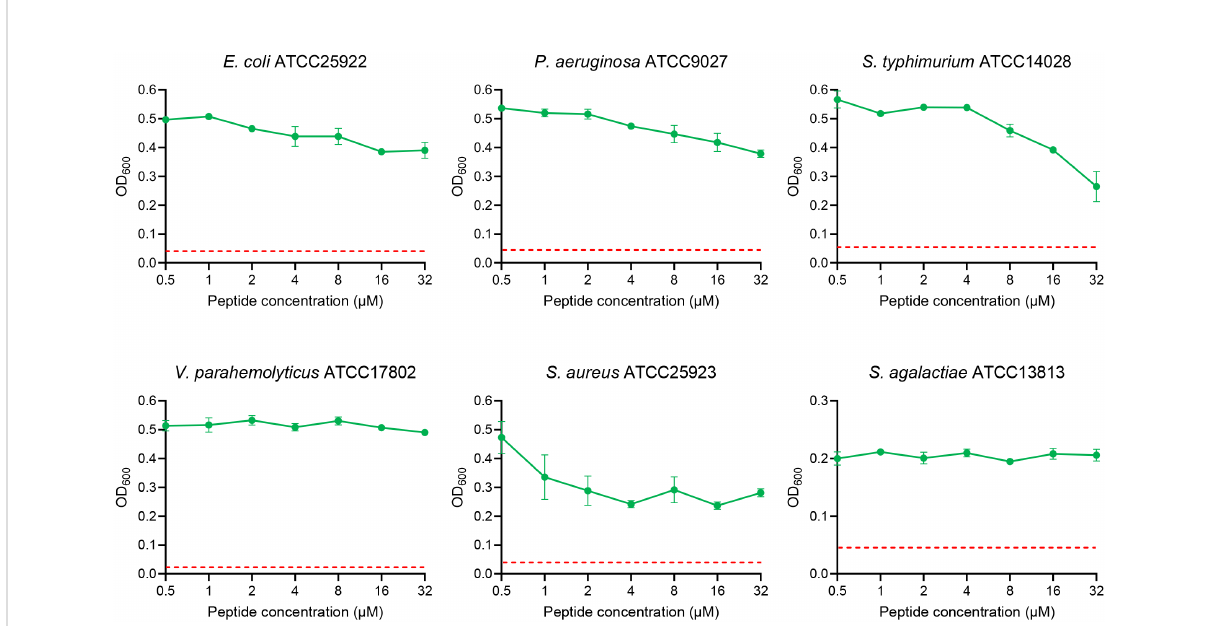
FIGURE 3 Antimicrobial activity of SKL17-2 against E. coli , P. aeruginosa , S. typhimurium , V. parahemolyticus , S. aureus , and S. agalactiae . The red dotted line represents the absorbance values of the